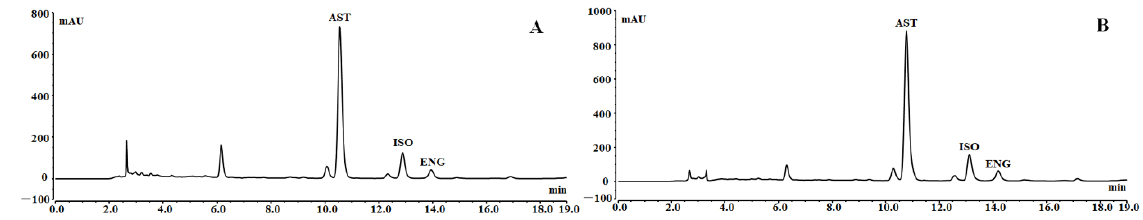
Figure 6. HPLC chromatograms of RSG extracts ( A ) and resin purified product ( B ).